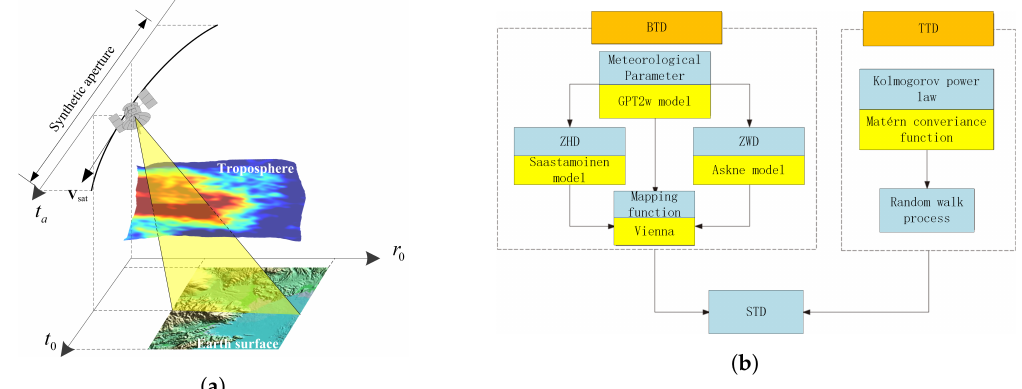
Figure 1. ( a ) Tropospheric propagation within SAR acquisition geometry. ( b ) The block diagram of the tropospheric delay model. BTD, background tropospheric delay; GPT2w, global pressure and temperature 2 wet; ZHD, zenith hydrostatic delay; ZWD, zenith wet delay; TTD, turbulent tropospheric delay; STD, slant tropospheric